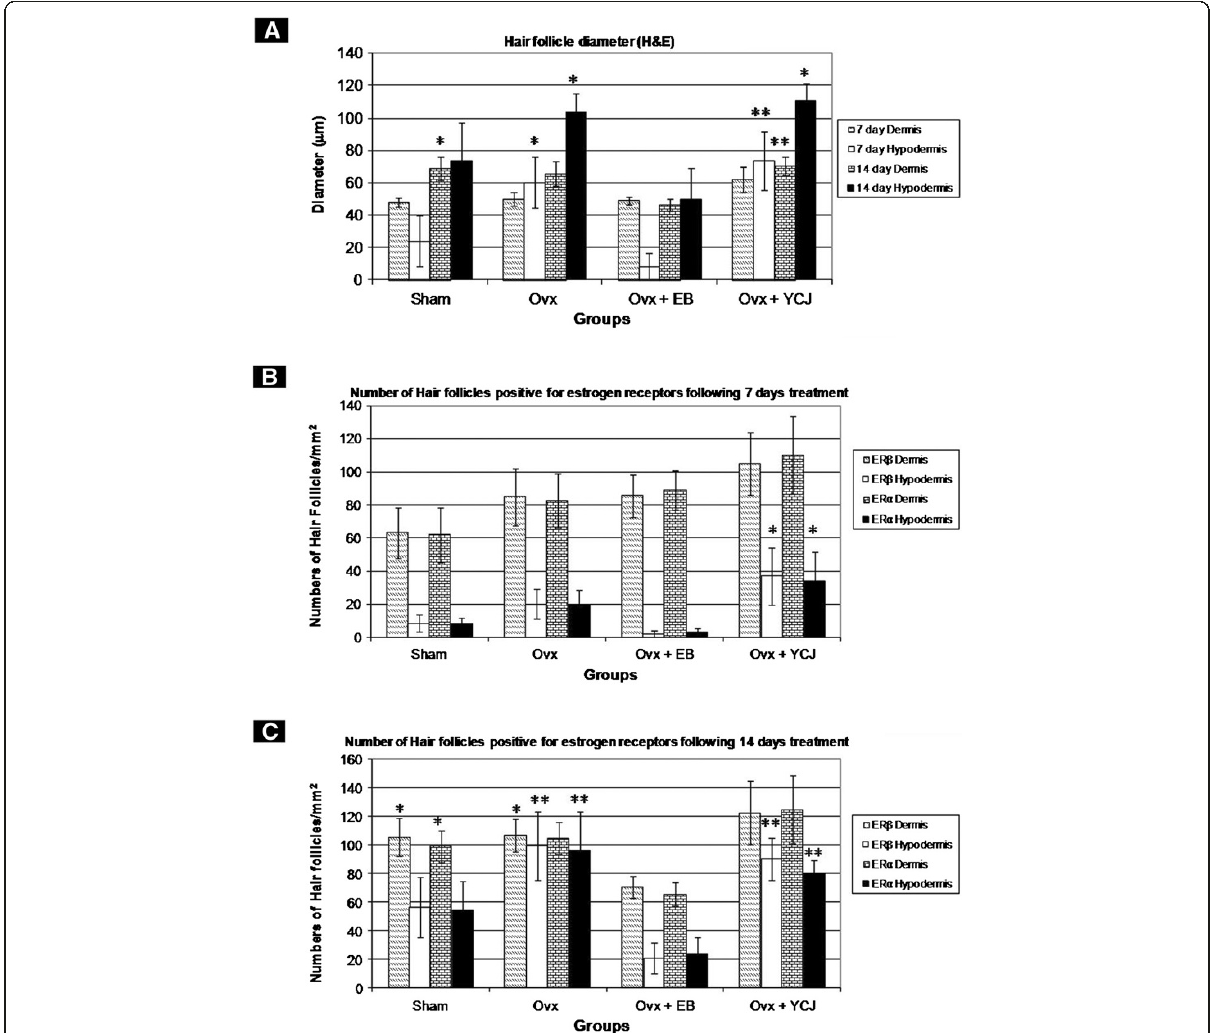
Figure 3 A. Diameter of dermal and hypodermal hair follicles in the dorsal skin wound areas of the various groups. The largest diameter was observed in the group receiving YCJ. B, C. Number of hair follicles positively-immunostained for ER- α , and ER- β , respectively. The number of these follicles was the highest in the group receiving YCJ. Ovx = ovariectomized group; Ovx + EB = ovariectomized group receiving estradiol benzoate; Ovx + YCJ = ovariectomized group receiving young coconut juice. n = 6 in each group. * P < 0.05, and **p < 0.01 compared with the ovx+EB group,